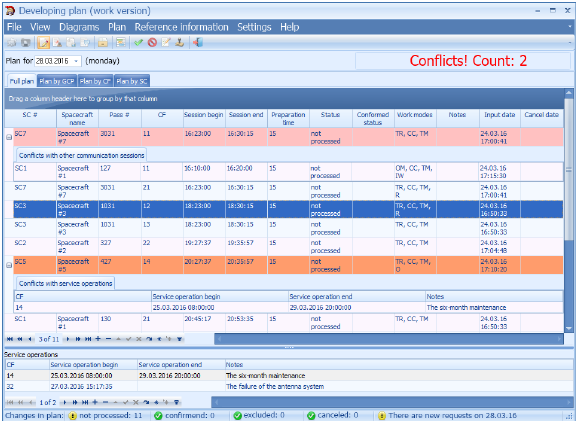
Figure 6. The main form of the program for devel- oping conflict-free